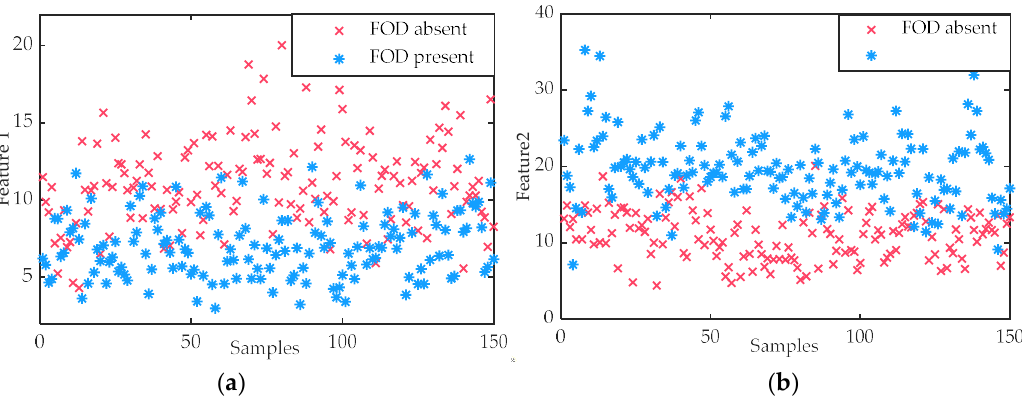
Figure 5. ( a ) Feature 1: the second-order central moment of the power spectrum. ( b ) Feature 2: the average power spectrum.